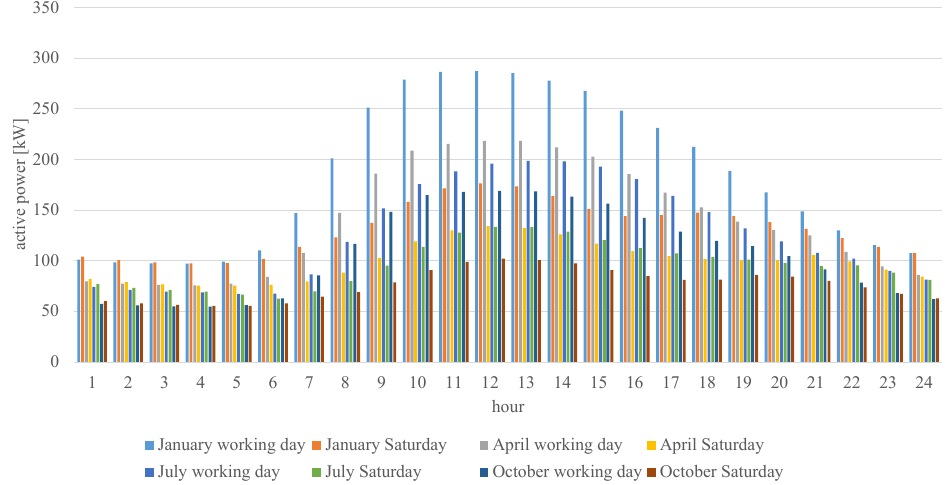
Figure 6. The assumed B23 profile based on energy bills and standard profiles from distribution network operator and maintenance manual.